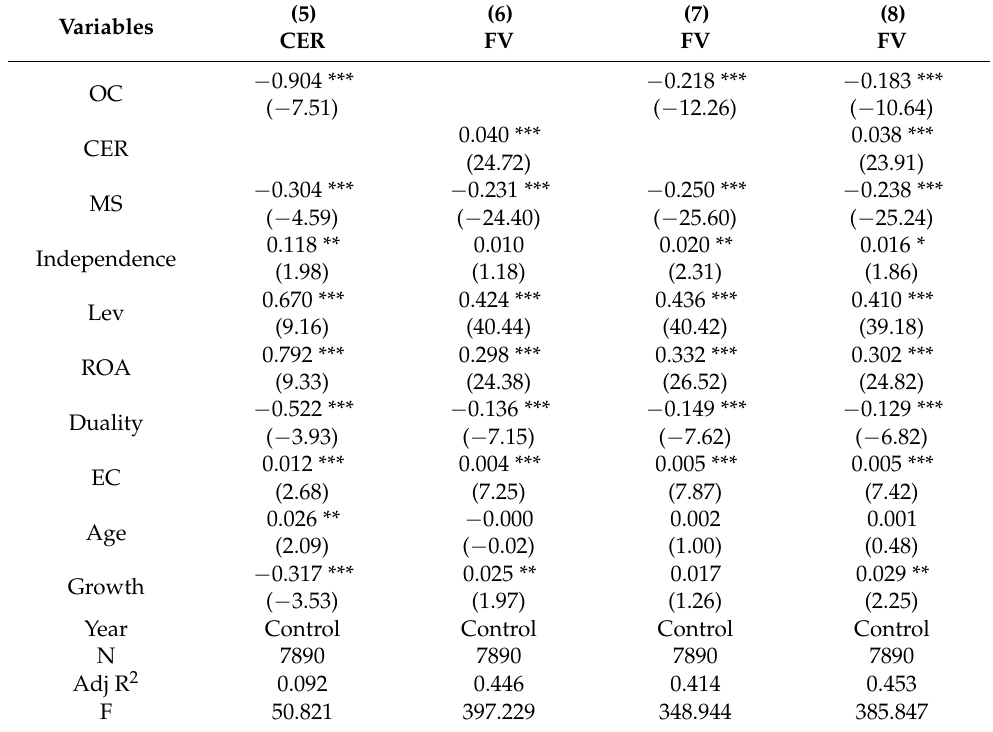
Table 6. Further